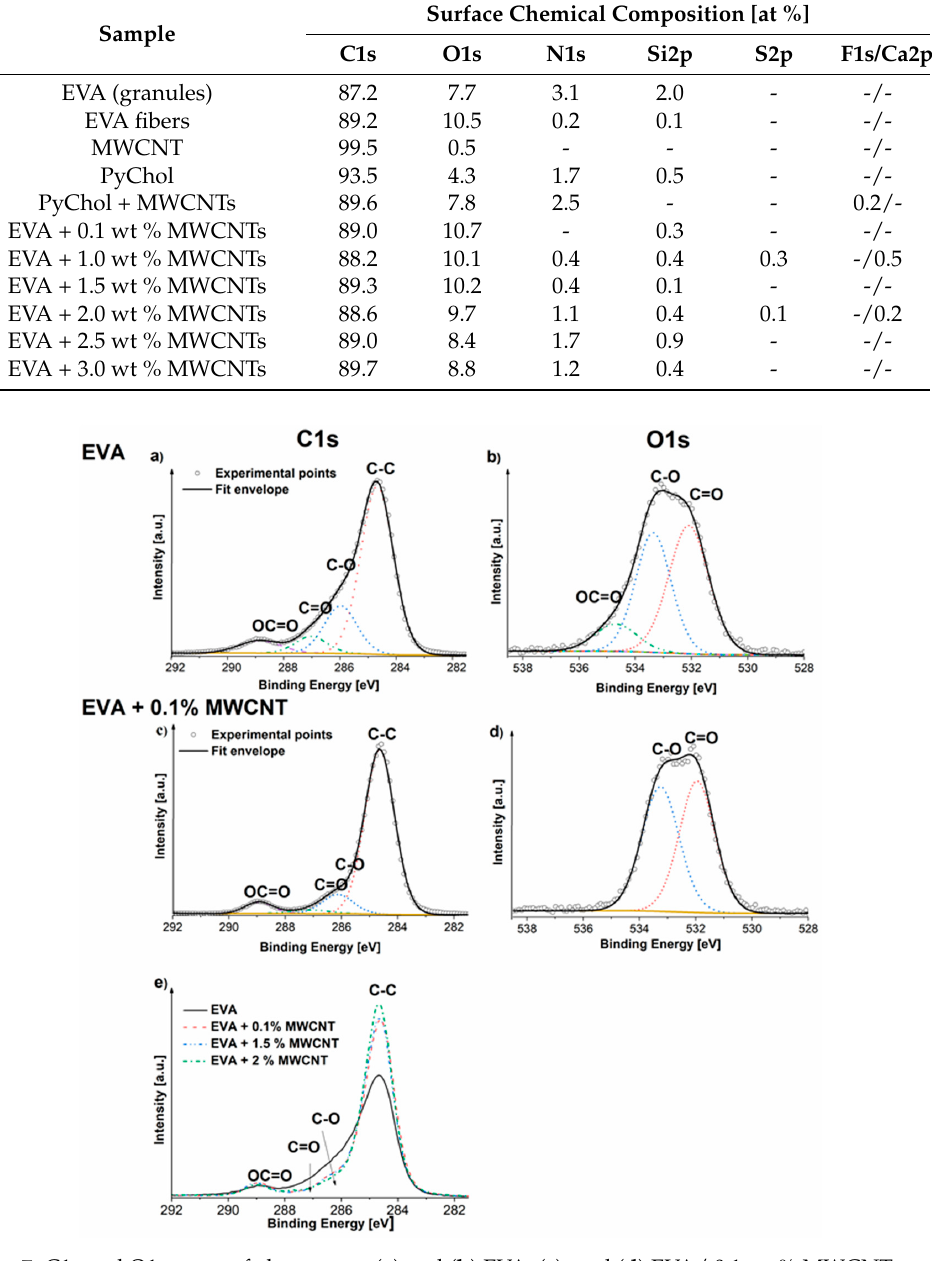
Figure 7. C1s and O1s scans of electrospun ( a ) and ( b ) EVA, ( c ), and ( d ) EVA/ 0.1 wt % MWCNTs, and ( e ) C1s comparison of selected